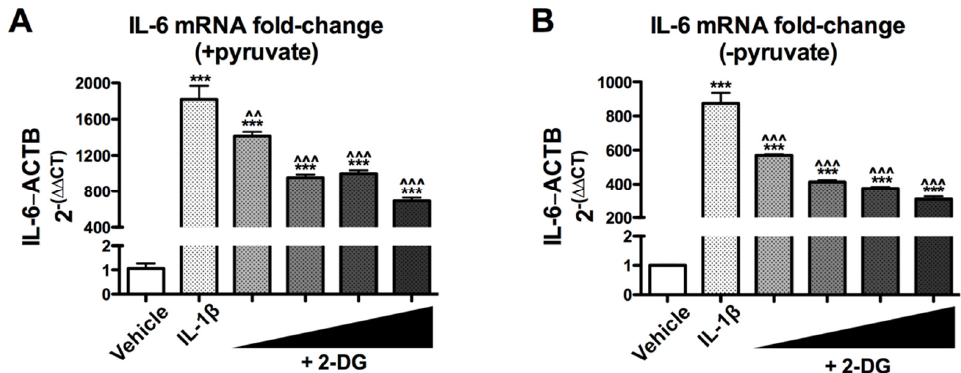
Figure 1. 2-DG blocks IL-1 β -induced inflammatory gene expression in human astrocytes in a dose-dependent manner. Human astrocytes were pretreated with increasing concentrations of 2-DG (1, 5, 10, and 20 mM) followed by treatment with IL-1 β 6 h prior to RNA isolation and gene expression analyses by RT 2 PCR. ( A ) Fold change of IL6 mRNA levels normalized to ACTB mRNA levels in the medium containing pyruvate. ( B ) Fold change of IL6 mRNA levels normalized to ACTB mRNA levels in the medium without pyruvate. One-way ANOVA was performed to the determine effect of treatment on IL6 cultured in media with pyruvate ( A ) [F (9, 10) = 83.52, p < 0.0001] and without pyruvate ( B ) [F (9, 10) = 116.1, p < 0.0001]. A post hoc Tukey’s test was conducted with corrected p -values shown (*** p < 0.001 vs. vehicle; ˆˆ p < 0.01; ˆˆˆ p < 0.001; vs. IL-1 β -treated cells). ANOVA, analysis of